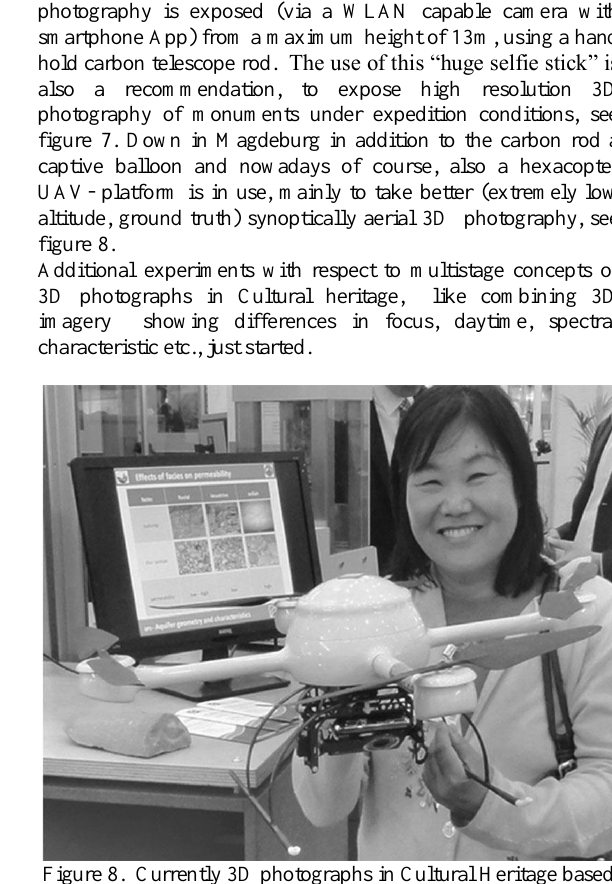
Figure 8. Currently 3D photographs in Cultural Heritage based on UAVs (civil drones) seem to promise a great